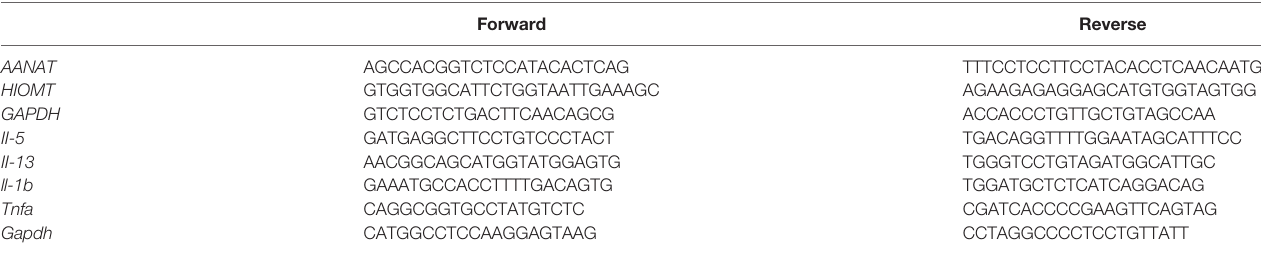
TABLE 2 | Primer sequence for